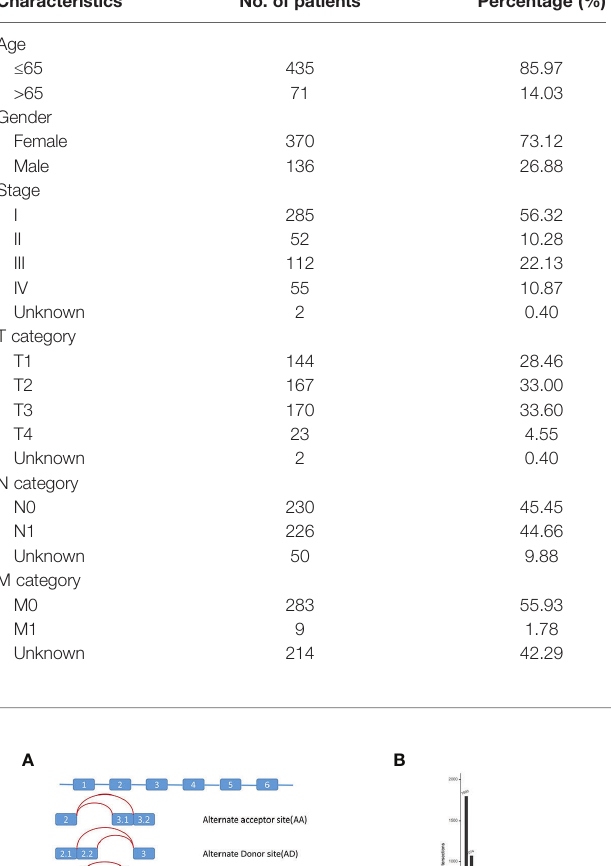
TABLE 1 | Characteristics of patients with THCA from TCGA database ( n = 506). Characteristics